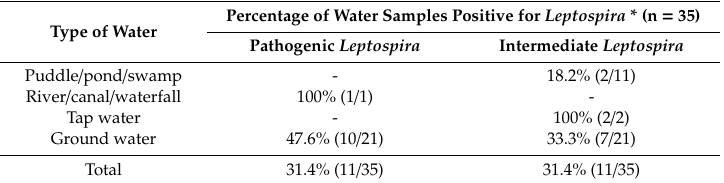
Table 3. Classification of Leptospira spp. isolated from water samples collected in this study. * Samples were positive by either or both culture and direct PCR.